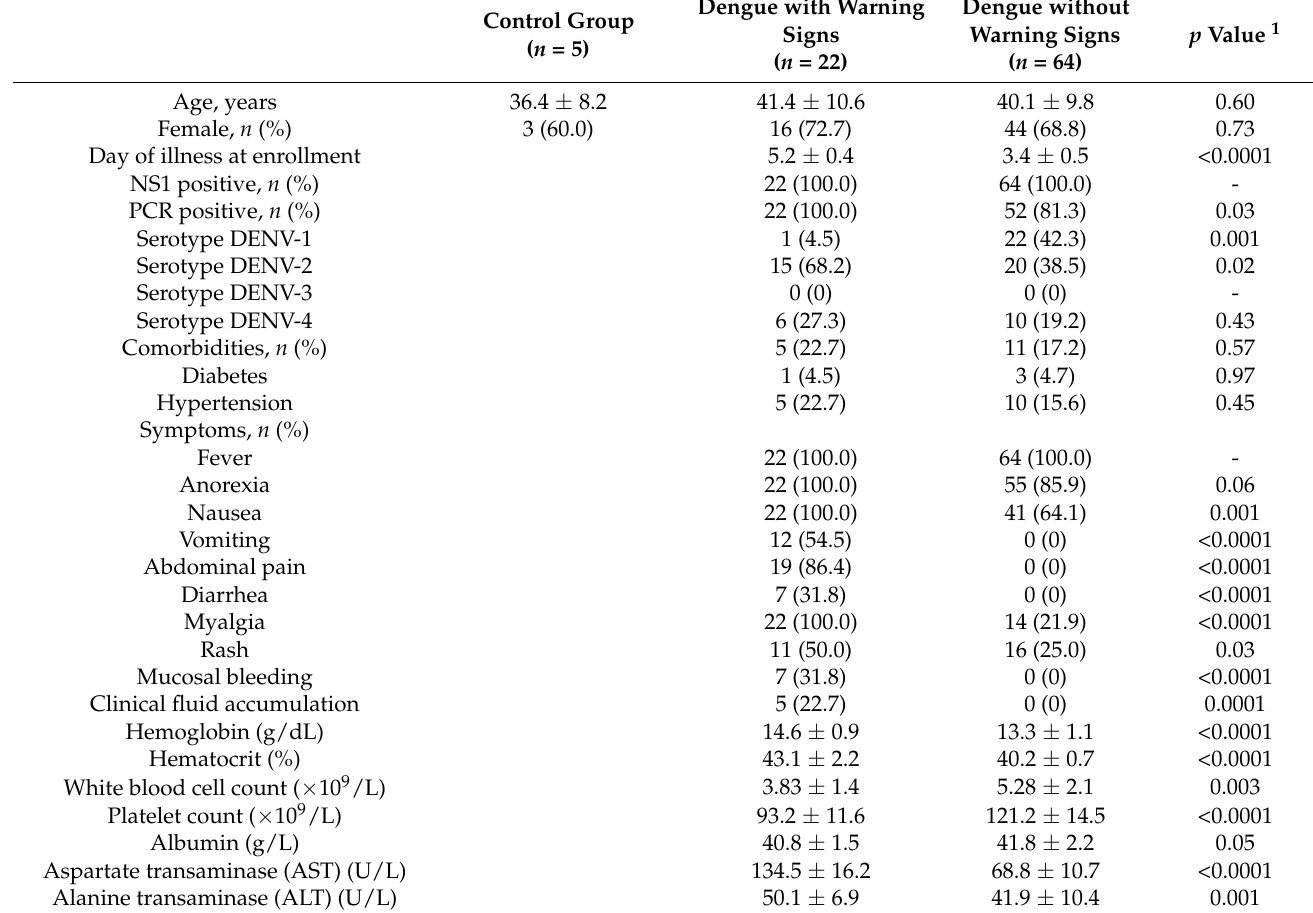
Table 1. Differences in baseline characteristics of dengue patients with and without warning signs, according to the World Health Organization 2009